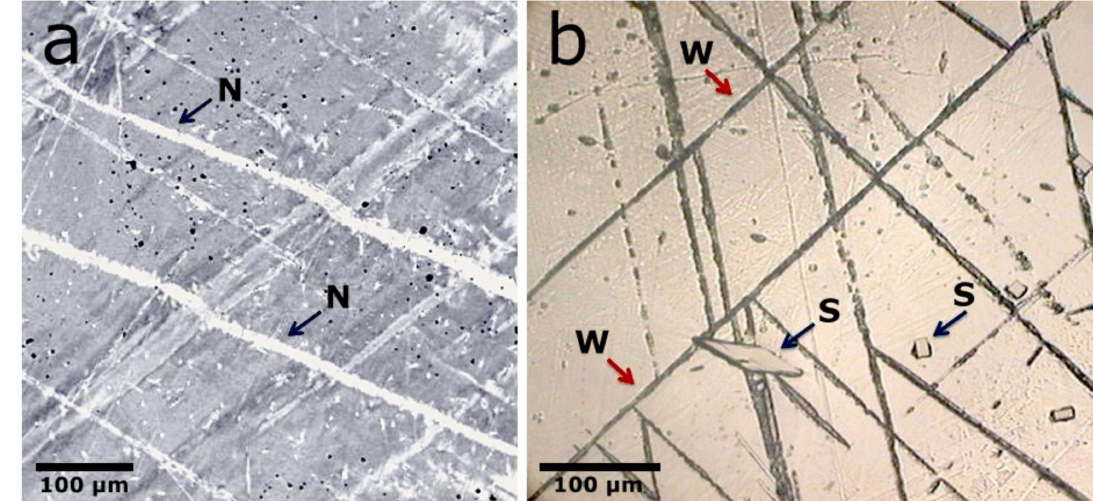
Figure 7. Micrographs of ( a ) unregistered iron meteorite showing Neumann bands (N), and ( b ) Campo del Cielo mete- orite demonstrating Widmanstätten patterns (W) and Schreibersite crystals (S). ( a ) Electron microprobe micrograph and ( b ) optical micrograph.